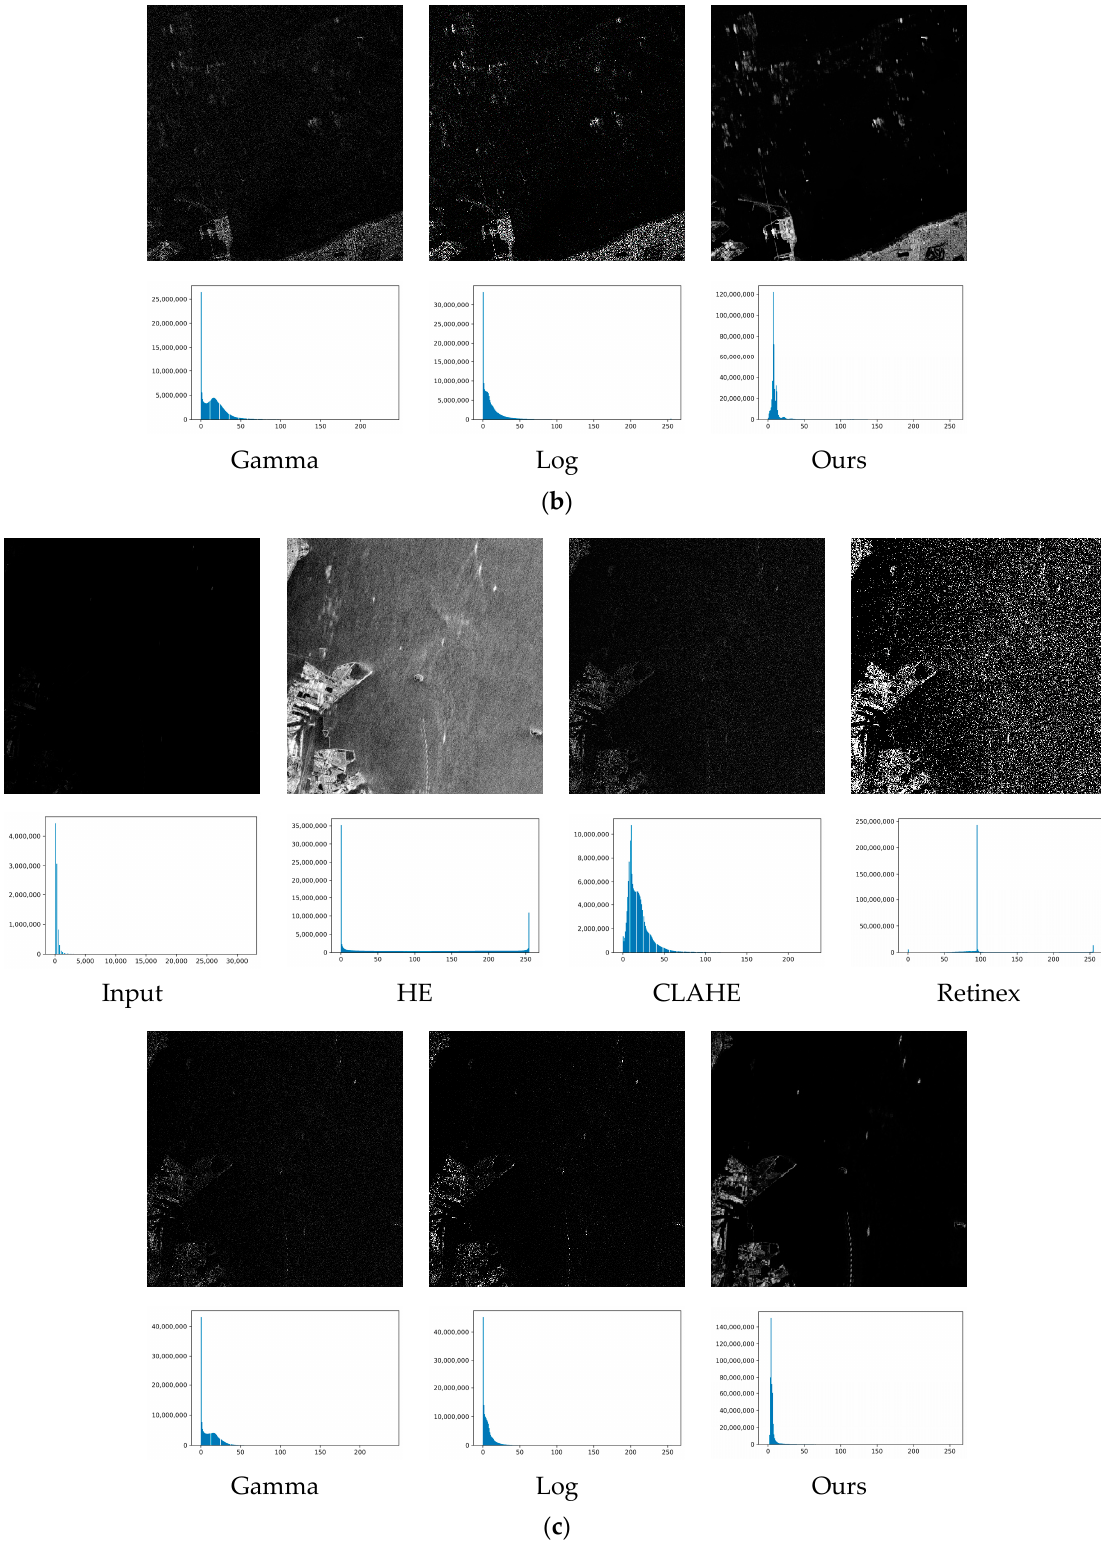
Figure 8. Visual results on real SAR images. The histogram exhibits the pixel distribution in the image. (a–c) Comparison of different single images.